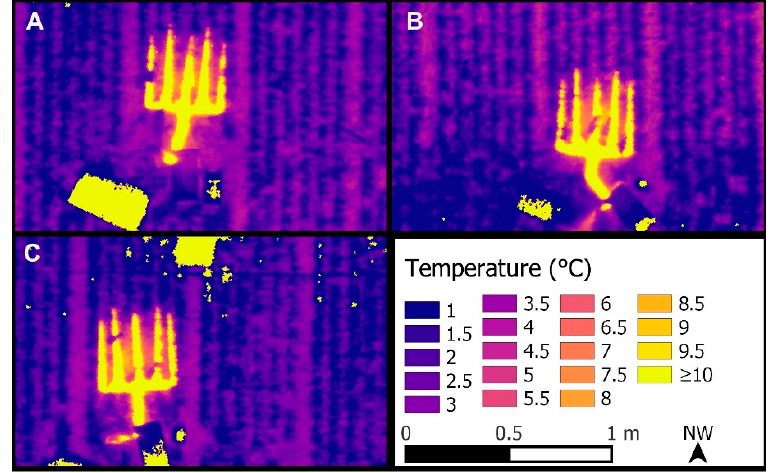
Figure 7. Thermal image captured by a drone-mounted FLIR Tau 2 640 25 mm camera above each heater between 6:17 to 6:21 am on 27 September 2017. ( A ) Heater one in ToS 7 (Wyalkatchem), ( B ) Heater two in ToS 5 (Wyalkatchem) and, ( C ) Heater three in ToS7 (Elmore). Note: The square areas with temperature ≥ 10 ◦ C behind the heaters correspond components of the plot heaters (solar panel and waterproof box), and the area above heater three is a thermal ground control target panel.